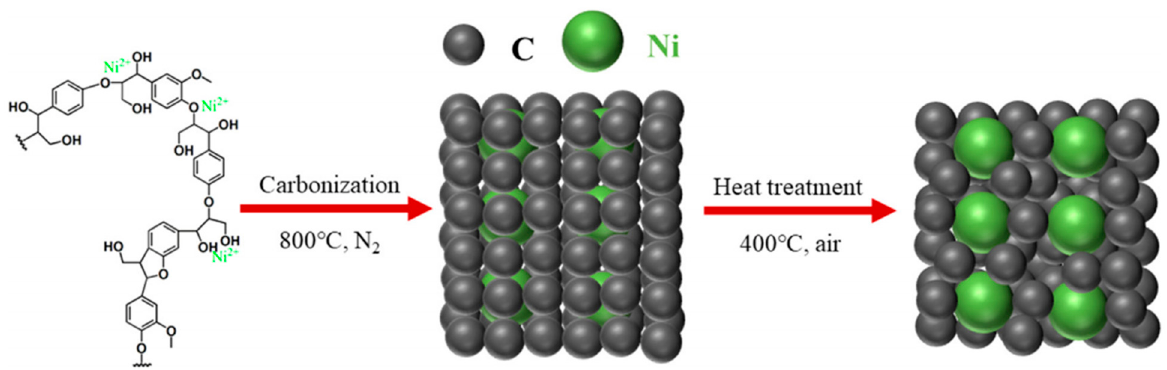
Figure 9. Schematic illustration of the construction of “inlaid type” catalyst. Reprinted with permission from Ref. [206]. Copyright 2019, Elsevier.